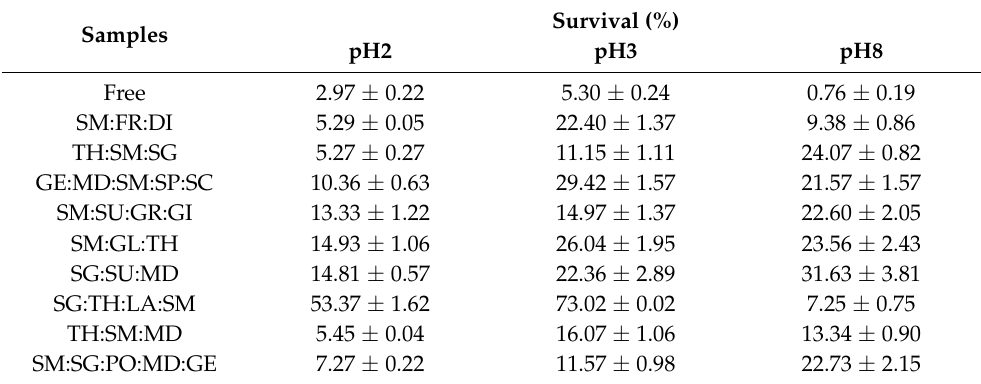
Table 4. Tolerance of microencapsulated LR-LFCA to acidic and alkaline